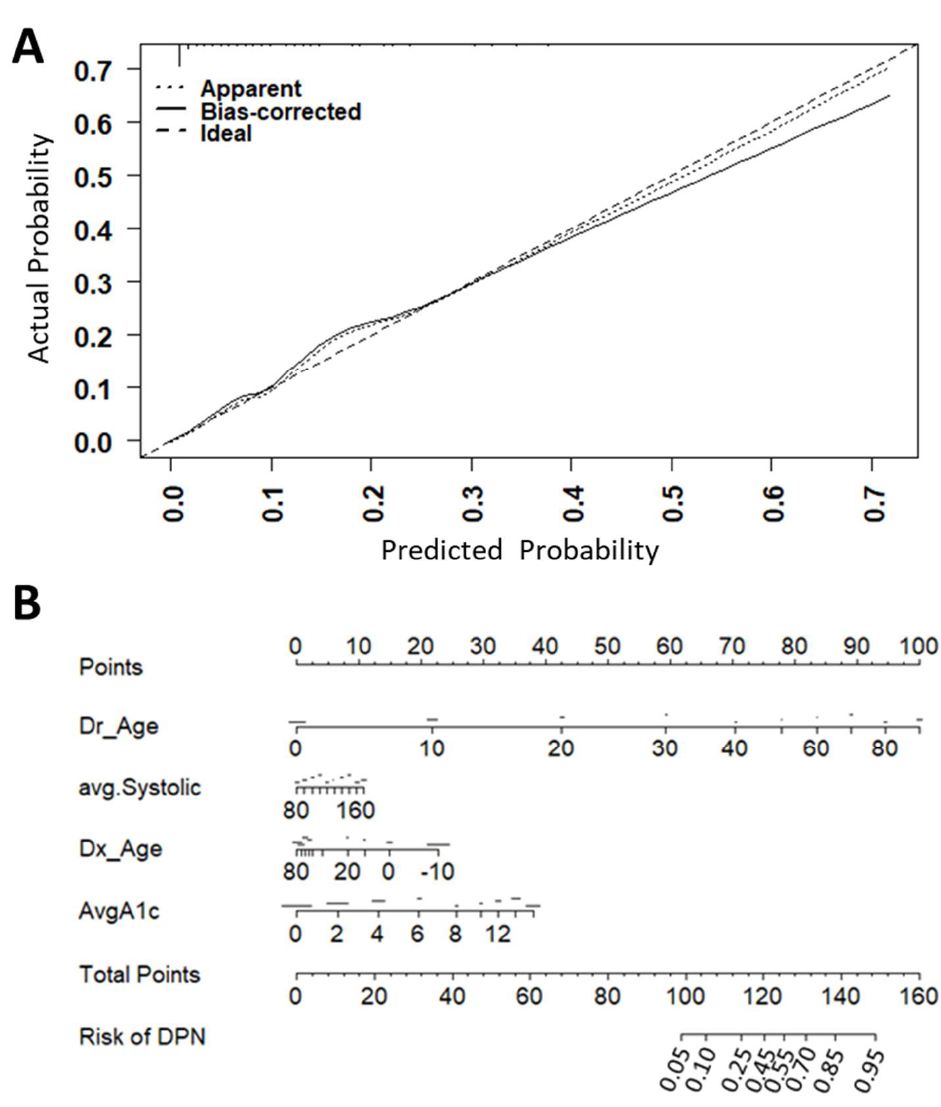
Figure 1. Calibration plot ( A ) and nomogram ( B ) for DPN in a multivariate logistic regression model. Calibration plots and nomograms for AN (C and D), DR (E and F), and DN (G and H) are presented in Supplementary Figure S1. We applied the four microvascular complication models to the PAGODA dataset with 500 iterations of bootstrapping to generate the calibration plot showing the actual probability of complication in the y-axis and the predicted probability of complication based on the models in the x-axis. A bias correction was applied by calculating the difference in probability between the bootstrap iterations and the model prediction with the full dataset. The nomogram was generated again based on the beta coefficients from the four logistic microvascular complication